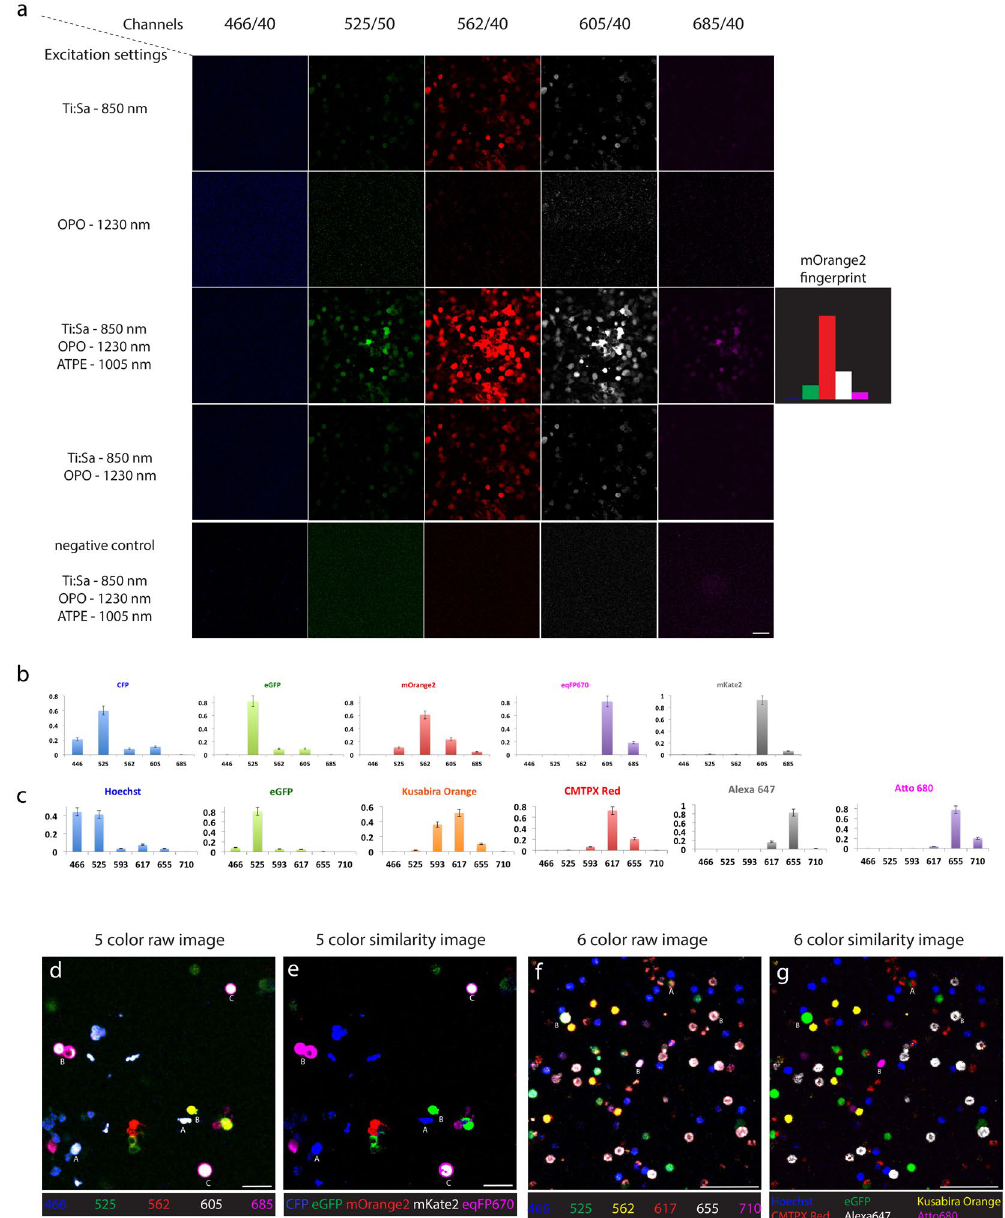
Figure 4. Similarity unmixing of spectrally multiplexed images of isolated cells. ( a ) Single color measurement of HEK cells expressing only mOrange2. Rows represent four excitation schemes: single 2P excitation at 850 nm by Ti:Sa laser; single 2P excitation at 1230 nm by OPO; the wavelength mixing 2P excitation at 850 nm, 1005 nm and 1230 nm by Ti:Sa laser, ATPE and OPO laser, respectively; dual unsynchronized 2P excitation at 850 nm and 1230 nm by Ti:Sa and OPO, respectively. The columns display images from five detection channels. The elements of the fingerprints are calculated as average signal values at the wavelength mixing scheme. ( b ) The fingerprints of five FPs, CFP, eGFP, mOrange2, mKate2, and eqFP670. ( c ) The fingerprints of six fluorophores, Hoechst, eGFP, Kusabira Orange, CMTPX Red, Alexa 647, and Atto 680. ( d , e ) Raw and unmixed images of HEK cell mixture expressing one of five FPs. Letter A indicates example of the crosstalk of the overexpressed signal from minimal spectrally overlapped FPs (case I and II cells in Fig. 3). Letter B indicates example of the crosstalk from strong spectral overlap (case III and IV in Fig. 3). Letter C indicates example of both crosstalk effects, signal overexpression and strong spectral overlapping. ( f , g ) Raw and unmixed images of splenocyte mixture expressing six fluorophores at one-fluorophore-per-cell condition. Letter A indicates example of the crosstalk of the overexpressed signal from minimal spectrally overlapped fluorophores (case I and II cells in Fig. 3). Letter B indicates example of the crosstalk from strong spectral overlap (case III and IV in Fig. 3). Scale bars, 50 μ